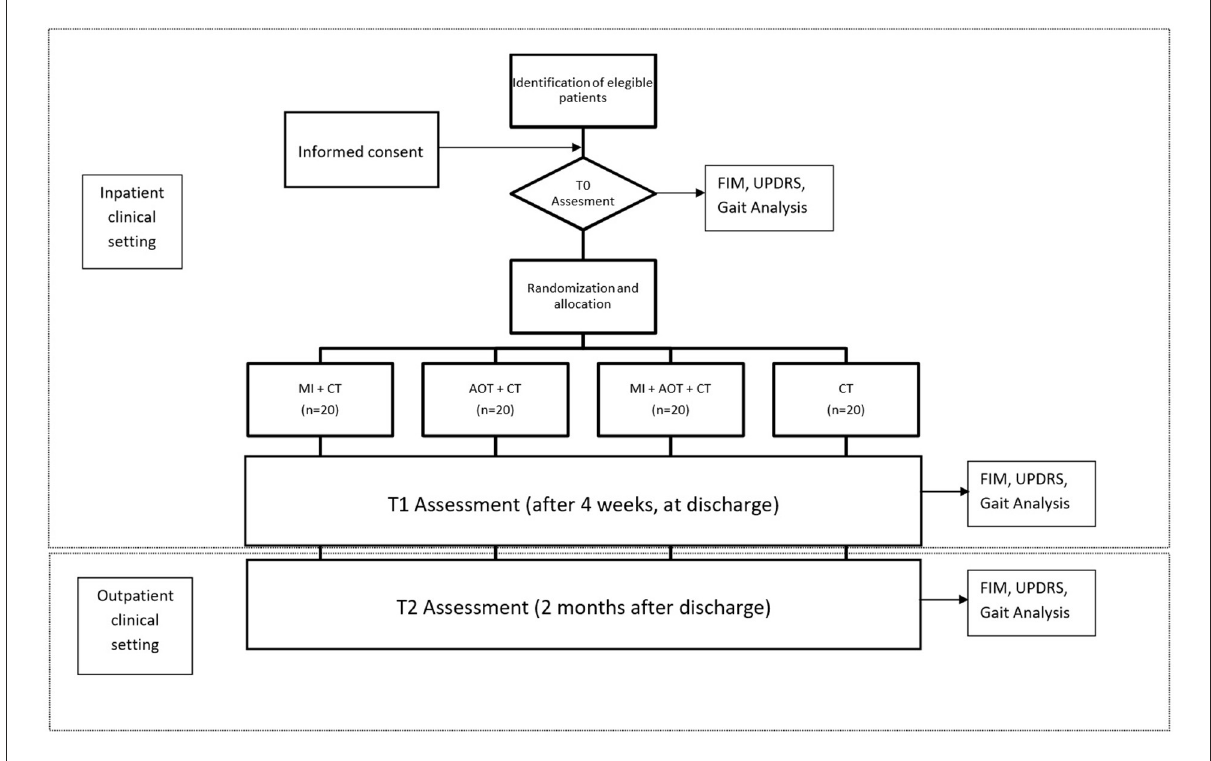
FIGURE1 Flow chart of the study